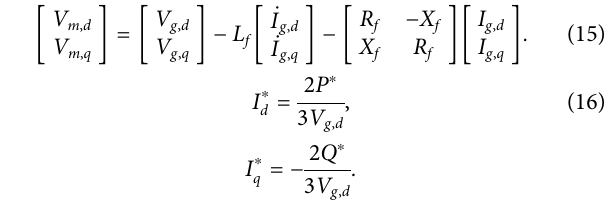
Frontiers in Energy Research |